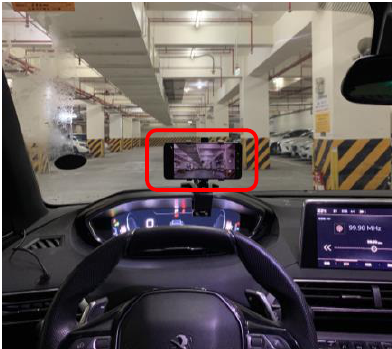
Figure 10 . Smartphone set above the dashboard.